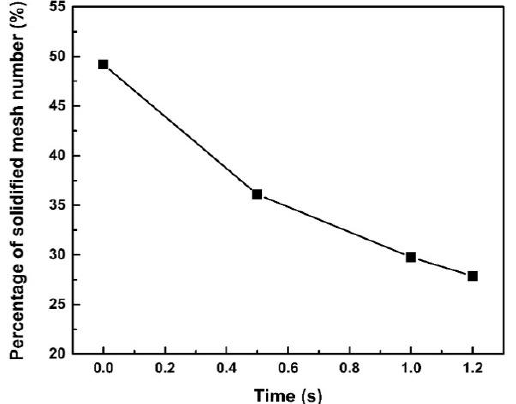
Figure 10. Variation in the percentage of solidified mesh number with standing time.